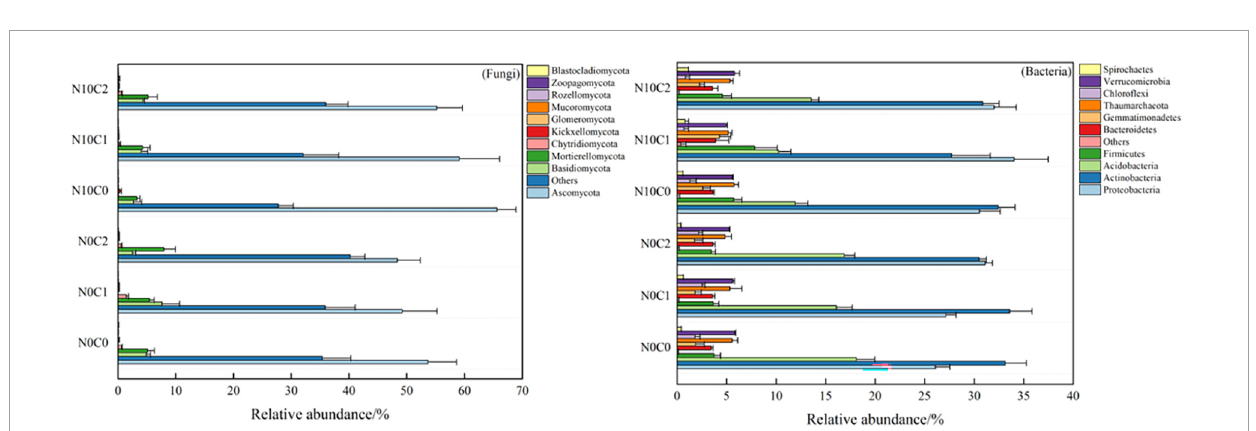
FIGURE5 Soil microbial community proportion at phylum level in N addition and litter manipulation treatments during 2014–2019 (mean).